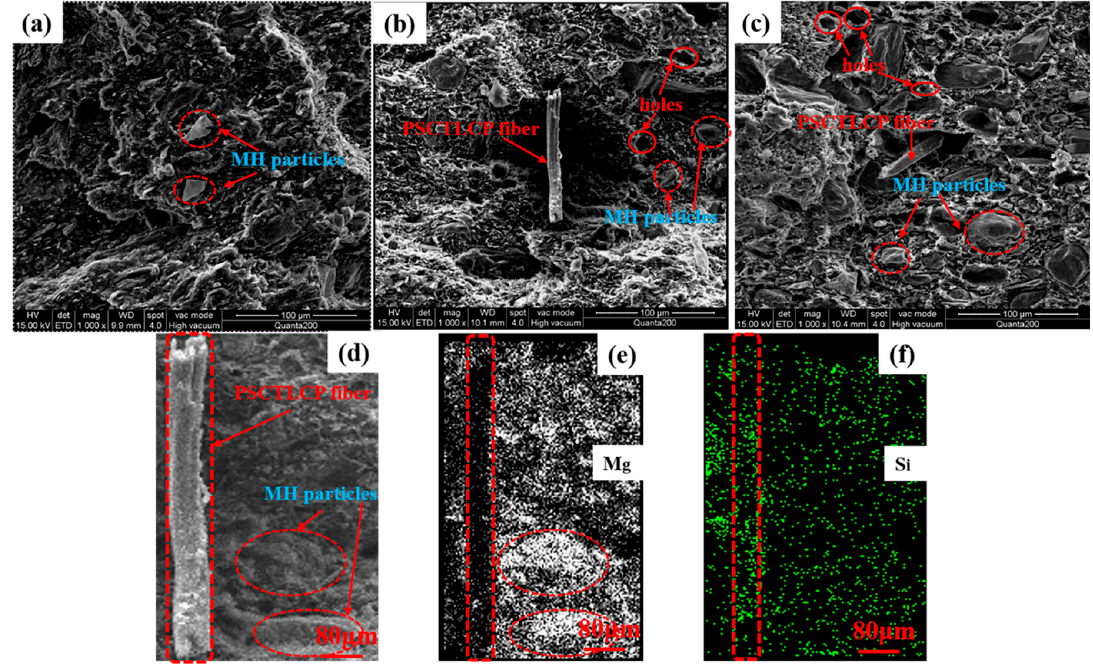
Figure 10. SEM images of ( a ) MH / LLDEP, ( b ) PSCTLCP-1.0, and ( c ) PSCTLCP-3.0. ( d ) Is a magnified image from (b), and elemental mapping images of ( e ) Mg, ( f ) Si.